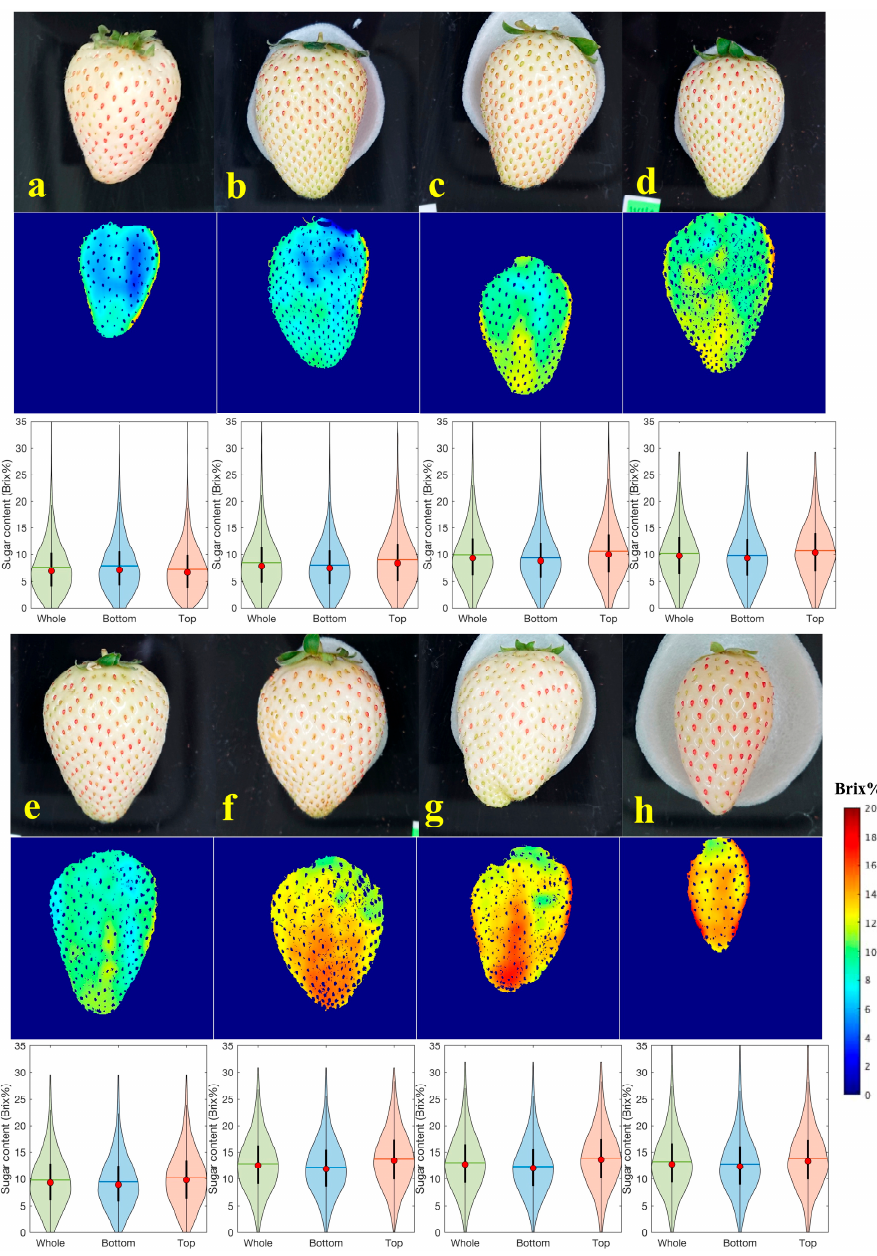
Figure 10. Prediction images and violin plots of Brix values using the PLSR model for white straw- berries. Violin plots represent the distribution of pixel Brix values for each ROI (whole flesh, bottom flesh, and top flesh). In order to display representative samples, samples were selected from the lowest to the highest sugar content and arranged in ( a – h ) order.